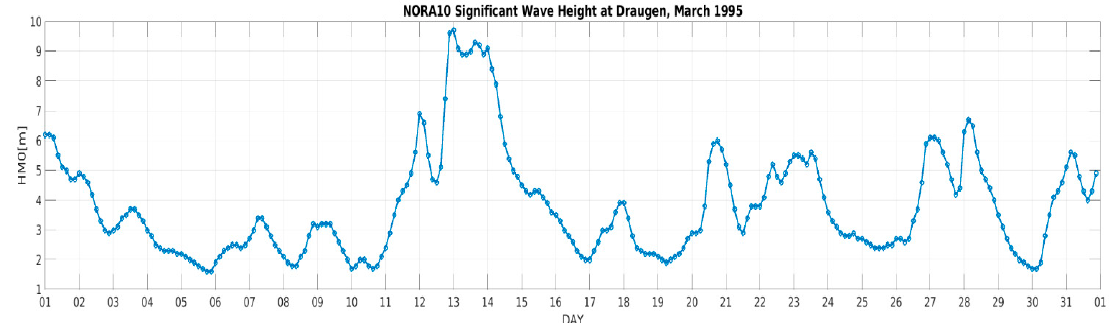
Figure 3. Significant wave height at Draugen, Haltenbanken during March 1995. Courtesy of the Norwegian Meteorological Institute, Bergen. The figure is reproduced from [17]; Magnusson, A.K. Personal communication 25th October 2019 related to the Draugen ringing event, March 1995 with permission from Magnusson October 2019.